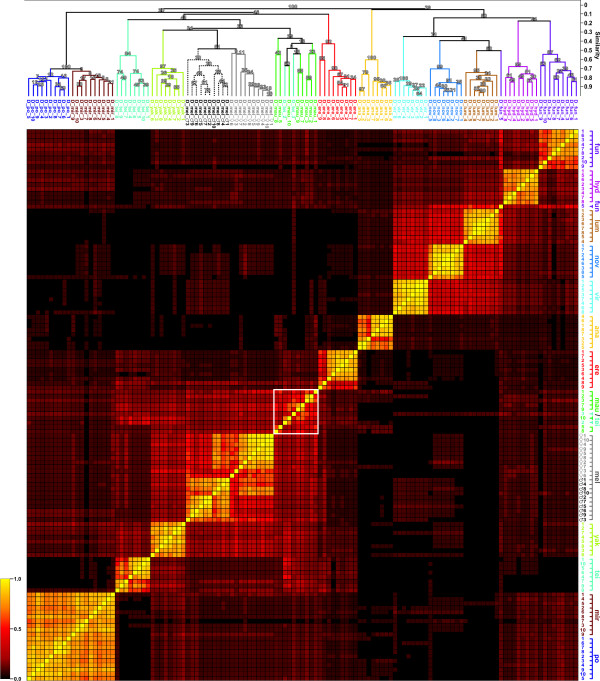
Results from cluster analysis using 208 selected peaks. For further information, please refer to the legend of Fig. 2.